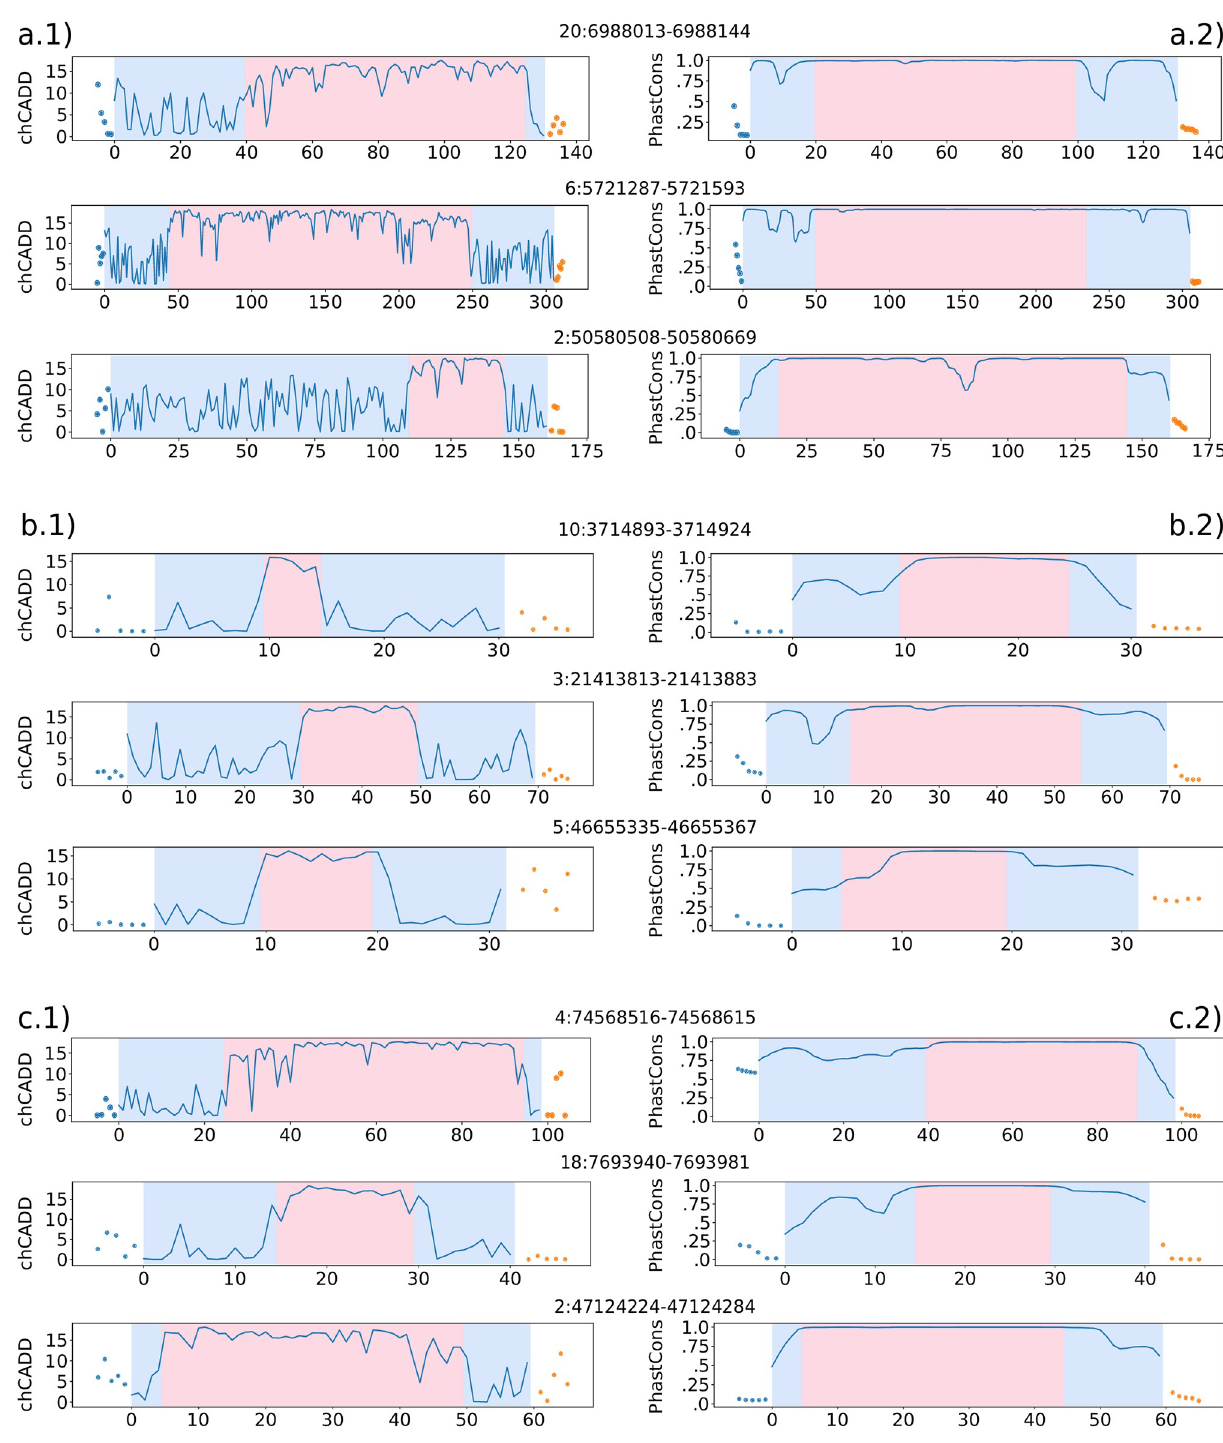
Fig 4. Change point analysis of the top 3 CNEs for each genomic feature, respectively (lncRNA, intronic, intergenic). CNEs are sorted based on the largest difference between the 2nd section and 1st or 3rd section for each of the three CNE classes respectively (lncRNA, intronic, intergenic). Change points were once computed based on maximum chADD score per site (a.1,b.1,c.1) and once on 23 sauropsids PhastCons scores (a.2,b.2,c.2). The dots in each plot display the scores for the 5 bp up- and downstream regions. The transition from blue to red background indicates the identified change